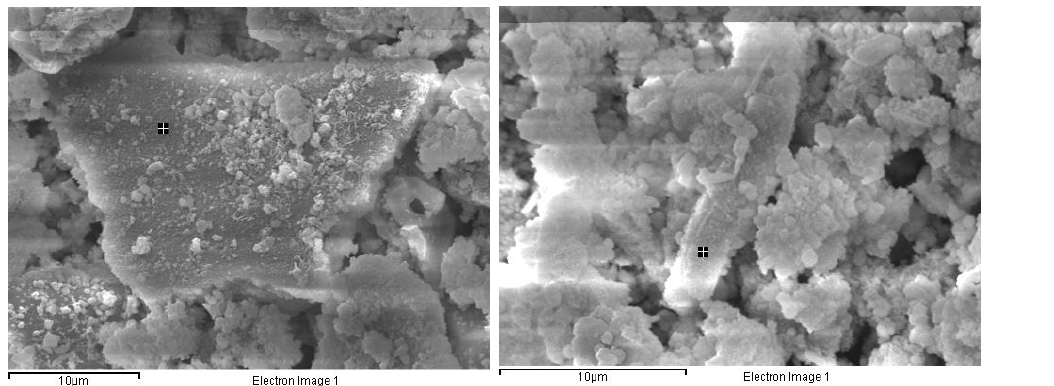
Figure 4. SEM images of calcium carbonate in treated fly ash samples.